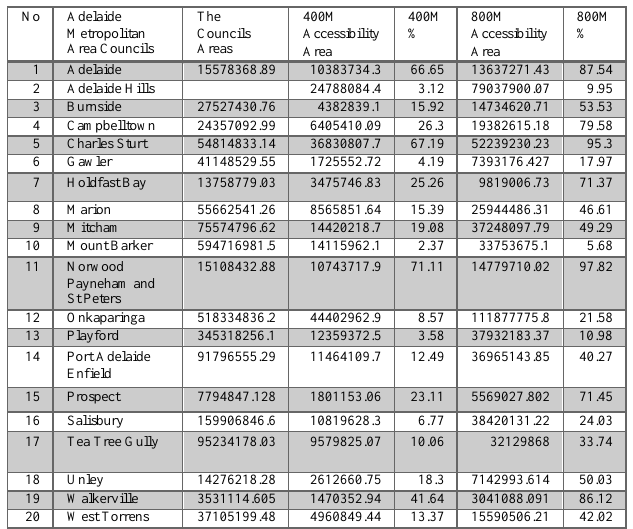
Table 2. Council area and walking accessibility of 400m and